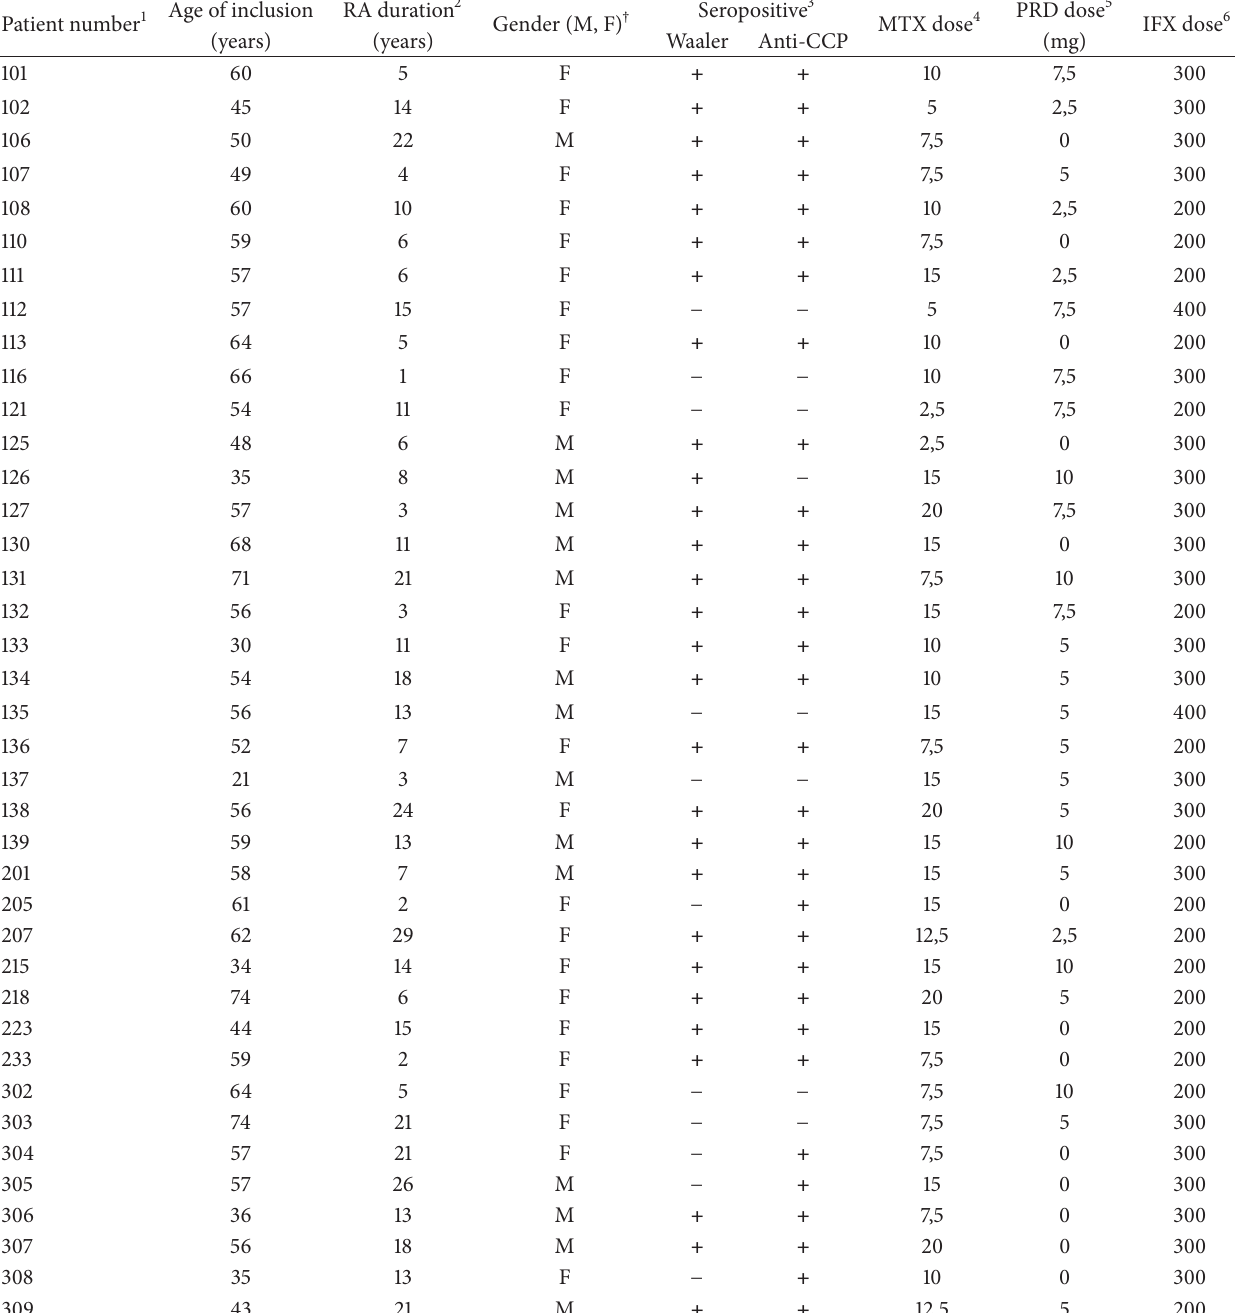
Table 1: Demographic data for the rheumatoid arthritis patient